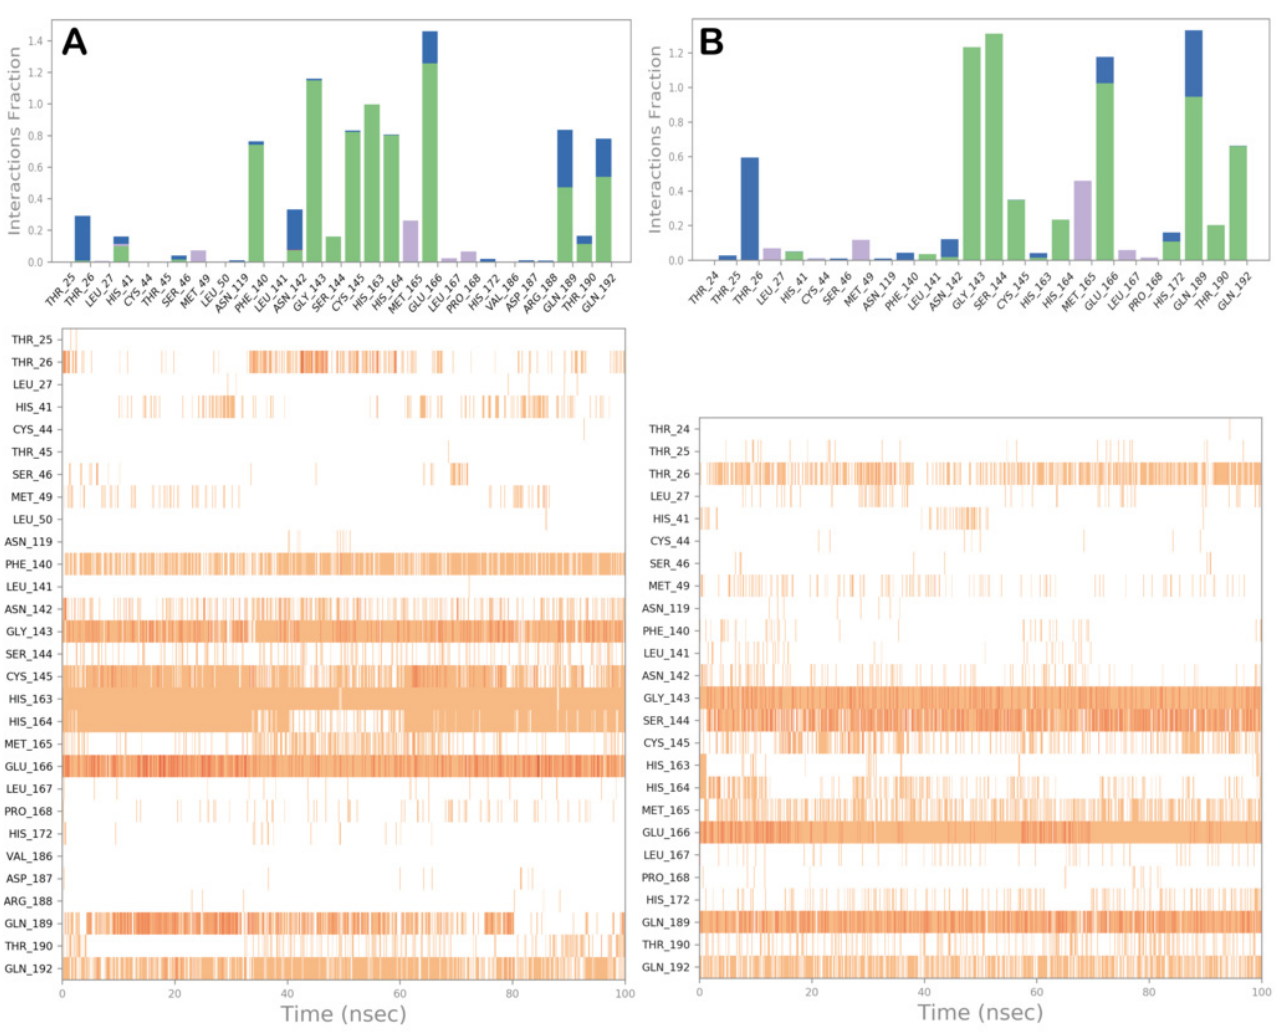
Figure 8. Compounds 6 (panel A ) and 7 (panel B ) monitored during the simulation. The contacts can be grouped by type and summarized, as shown in the plots. Grouping protein–ligand interactions into four types: H-bonds (green), hydrophobic (gray), ionic (magenta), and water bridges (blue). In the second graph of the picture is reported a timeline representation of the contacts. Some residues make more than one specific contact with the ligand, which is represented by a darker shade of orange. Pictures were generated by the simulation interaction diagram available in Desmond via Maestro (Maestro, Schrödinger LLC, release 2020-3).